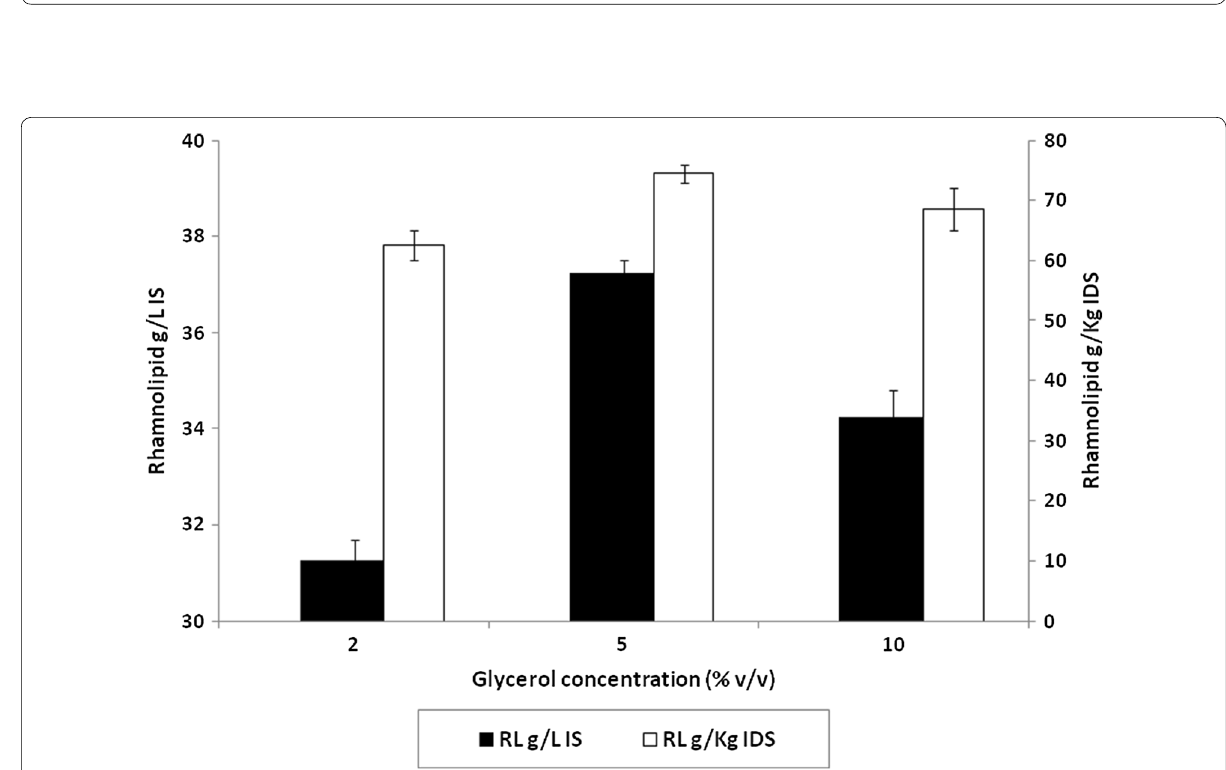
Fig. 3 Effect of variable glycerol concentrations on RL production by P. aeruginosa 15GR in SSF. Values plotted are the means of triplicate results while error bars indicate the standard deviation of the